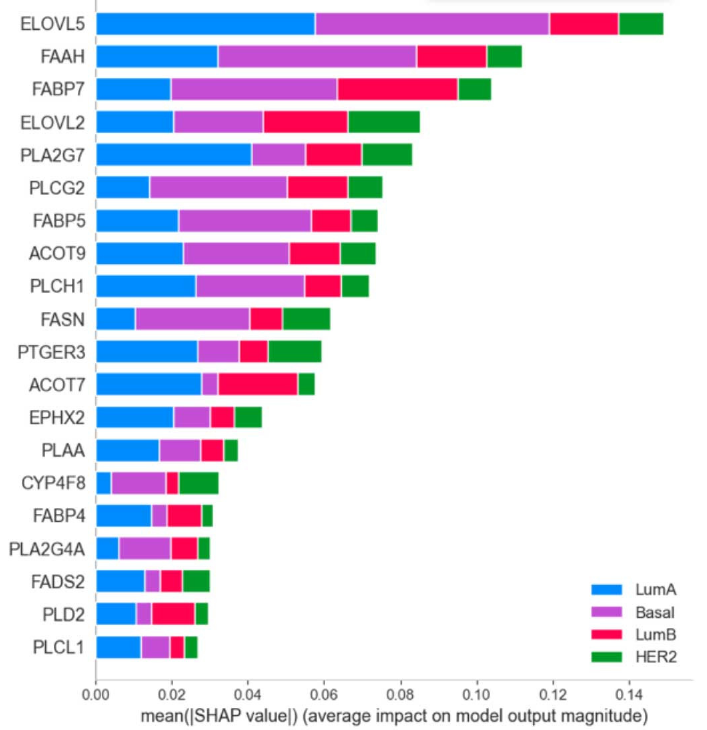
Figure 6. Most important features for classification between molecular subtypes of breast cancer. Importance was evaluated by SHAP values. Each color represents the importance of the separation of the corresponding class from the others.